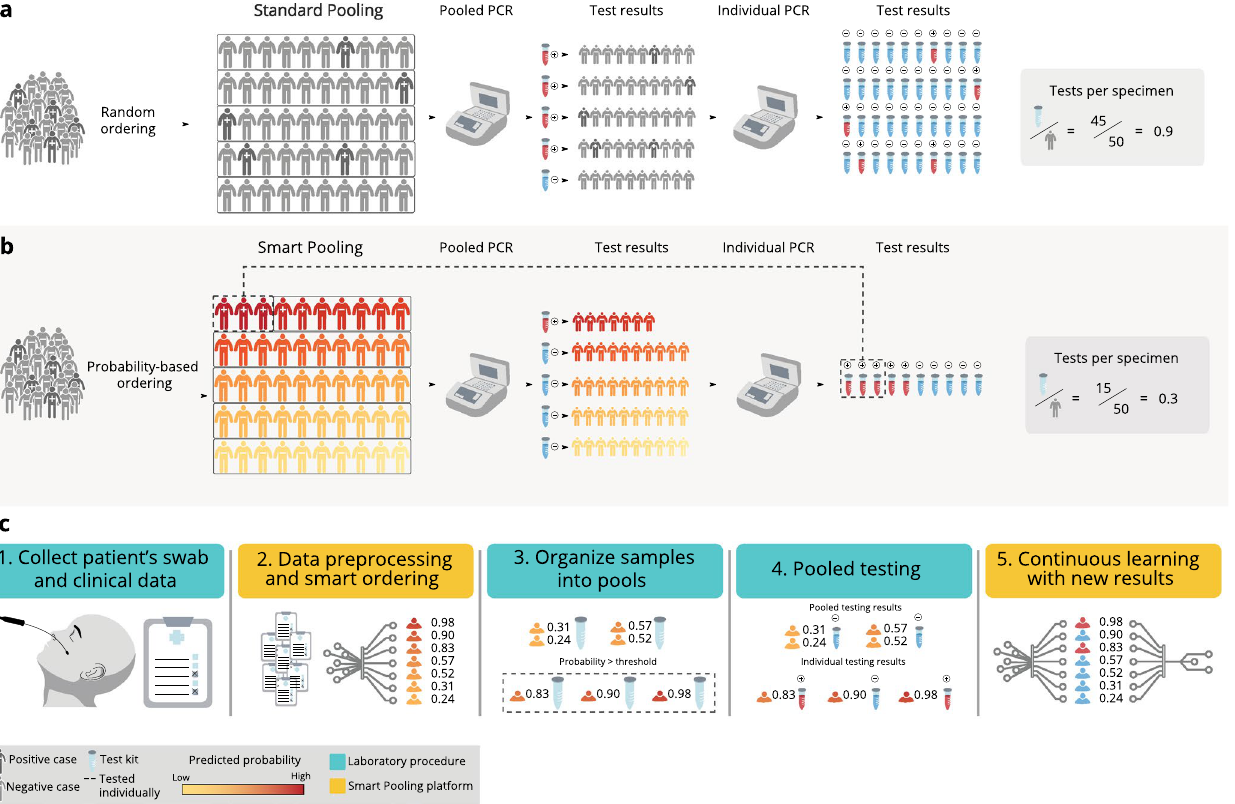
Figure 1. Smart Pooling makes pooling methods efficient even at high disease prevalences. ( a ) In standard Dorfman’s testing methods, samples are pooled randomly. As prevalence increases, the efficiency of pooling without a priori information drops rapidly, making the strategy unviable. ( b ) Smart Pooling tackles this problem by thresholding samples according to the automated predicted risk probability, based on the sociodemographic characteristics. If the risk probability of a sample surpasses the defined threshold, this sample goes directly to individual testing. We arrange samples into pools with similar risk probability. ( c ) The Smart Pooling pipeline directly integrates machine learning with laboratory